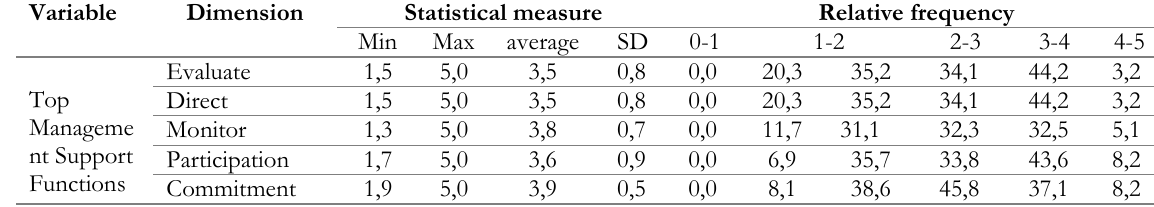
Descriptive Statistics of Top Management Support